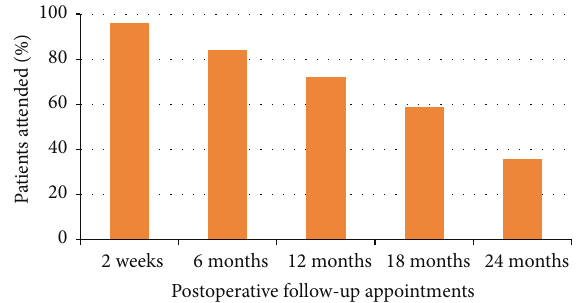
Figure 1: Patients’ attendance based on follow-up